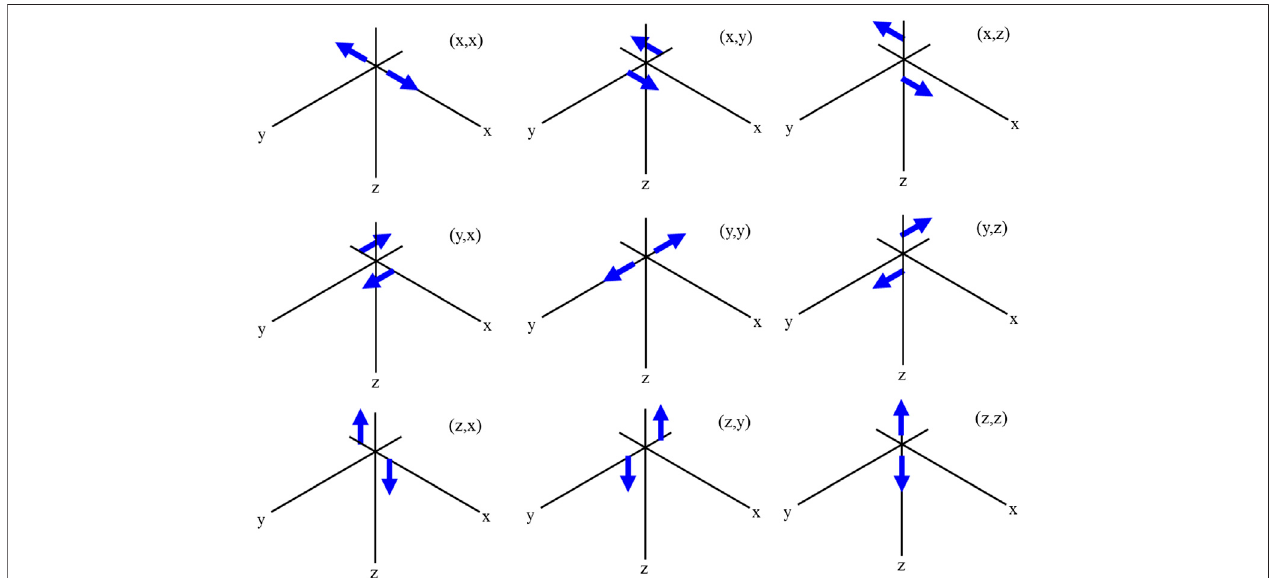
FIGURE 6 | The moment tensor comprising nine sets of two vectors.